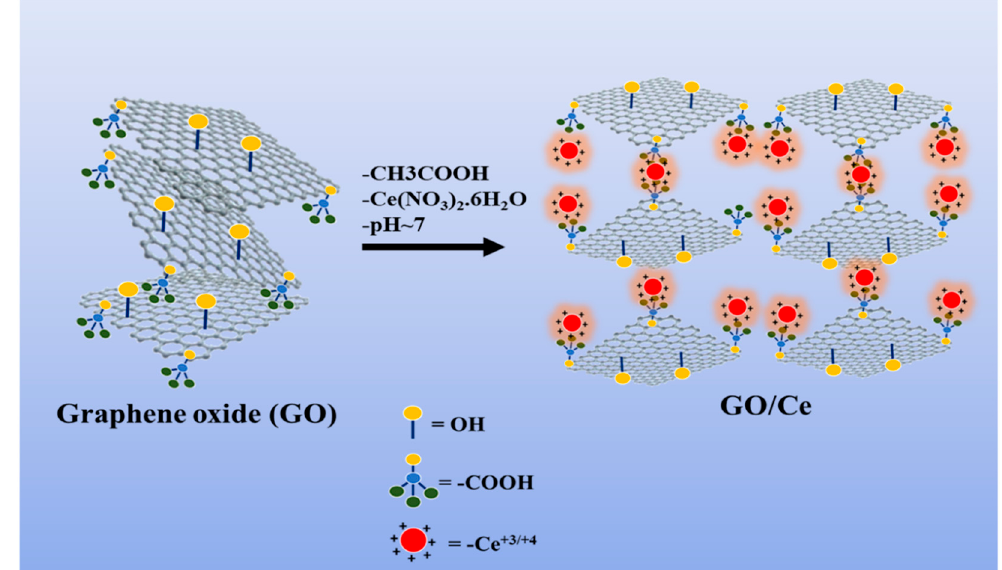
Scheme 1. Illustration showing the synthesis of GO/Ce hybrid composite material from graphene oxide (GO).